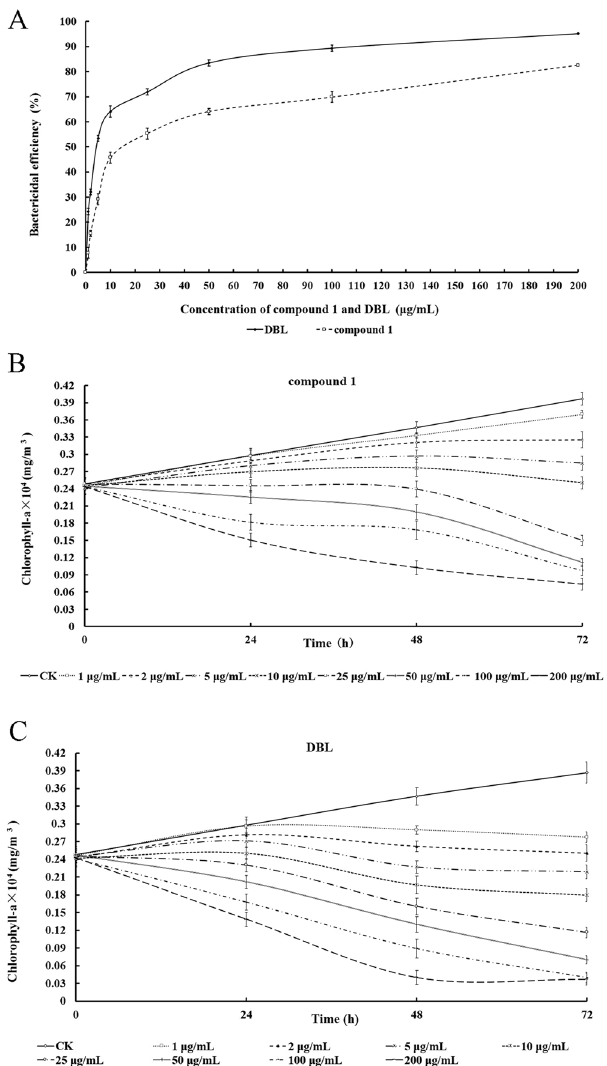
Figure 2. Anticyanobacteria activities of compound 1 and DBL against M. aeruginosa . ( A ) The bactericidal efficiency of compound 1 and DBL with different concentrations (1 to 200 μ g/mL) against M. aeruginosa cells were calculated by measuring the cell density for 72 h; ( B ) The chlorophyll a concentrations of M. aeruginosa exposed to compound 1 with different concentrates at 24, 48, 72 h; ( C ) The chlorophyll a concentrations of M. aeruginosa exposed to DBL with different concentrates at 24, 48, 72 h. Experiments were performed in triplicate. Error bars represent the